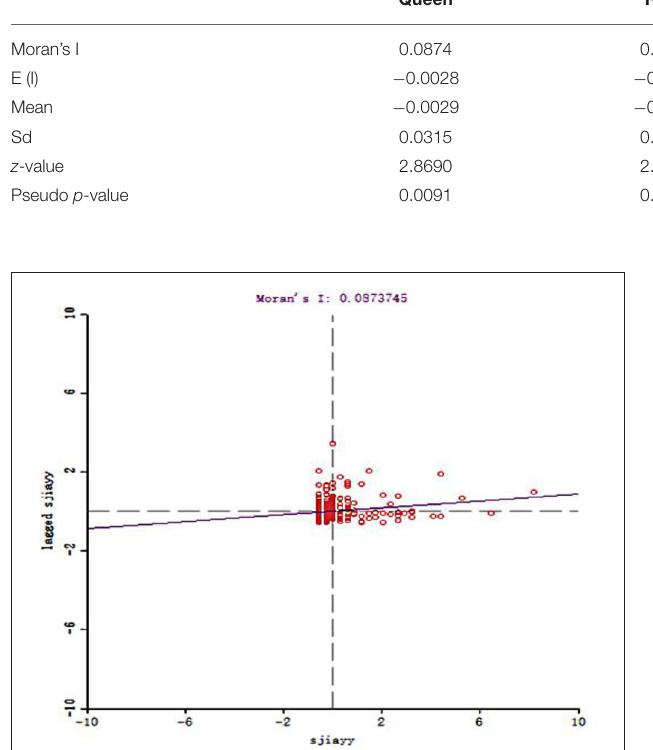
FIGURE 3 | Moran scatter plot of China Elite Hospital.